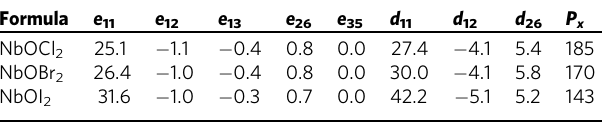
Sheet piezoelectric stress tensor elements e ij are in units of 10 − 10 C m − 1 and piezoelectric strain tensor elements d ij are in pm V − 1 . Piezoelectric tensor elements that are zero due to symmetry of thespace groupareomittedhere.Spontaneous polarizationalong the x- direction( P x ) in pCm − 1 is calculated as the difference between the polarization of the equilibrium and symmetric